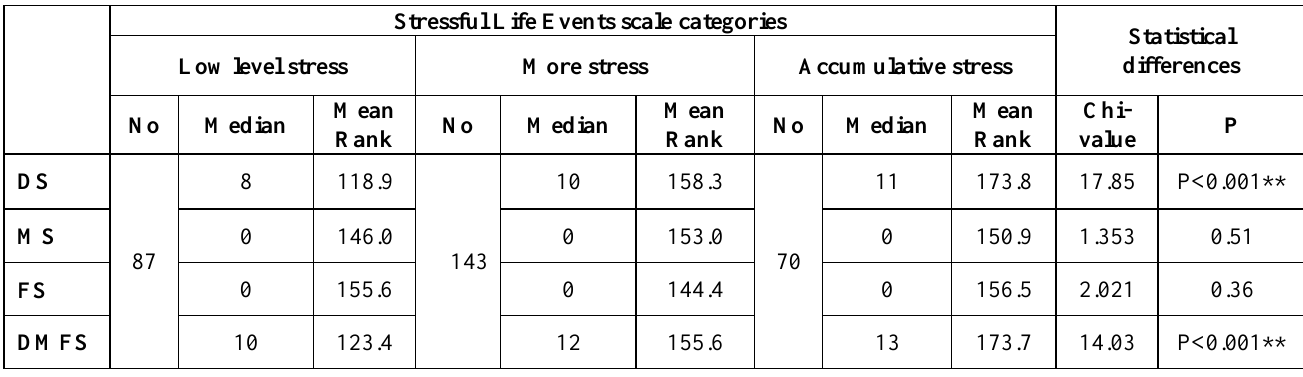
Table (1): Caries experience (DMFS) and its components (DS, MS, FS) (Median, Mean Rank) according to categories of Stressful Life Events scale.